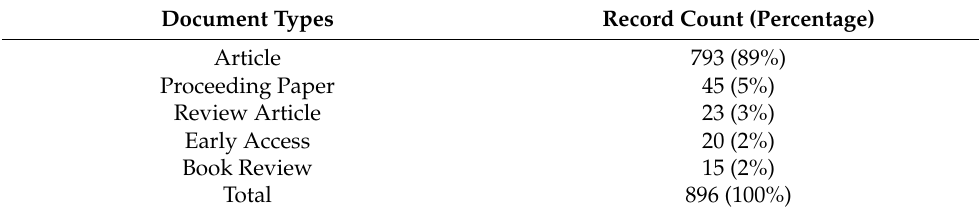
Table 2. Bibliometric selection by document